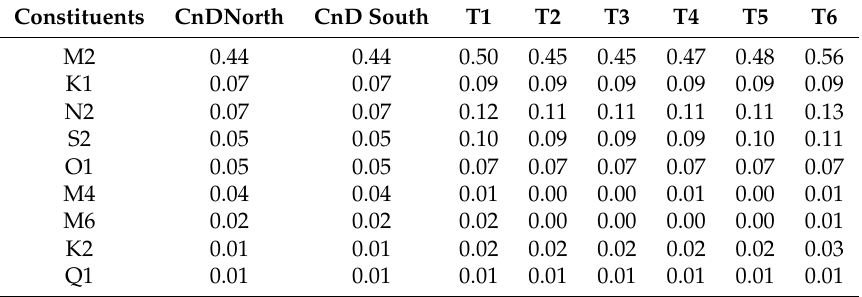
Table 1. Tidal constituent amplitude (m) at each side of open boundaries (see Figure 2 for the location).